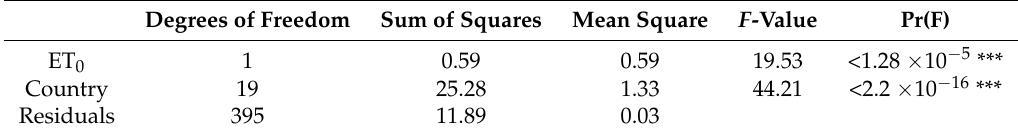
Table A5. *** represent estimates that have p -values smaller than